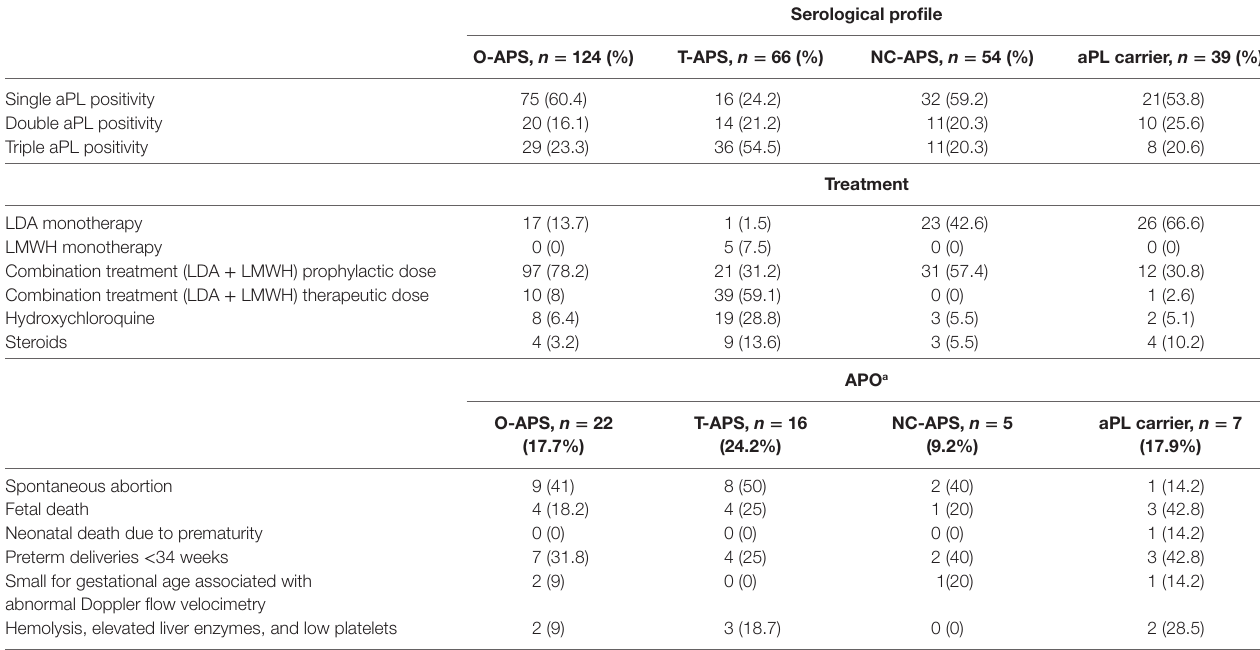
Table 6 | Description of serological profile, treatment, and prevalence of adverse pregnancy outcome (APO) in the subgroups (all pregnancies included in the study).